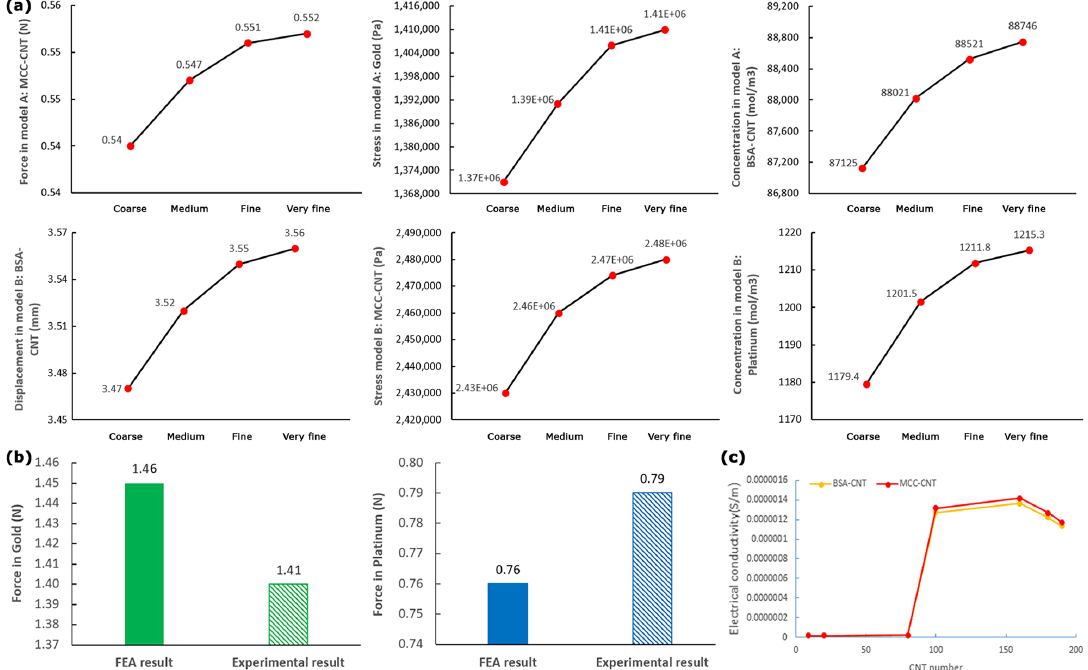
Figure 4. ( a ) Grid independence study for force, linear displacement, cation concentration, and stress values. ( b ) Comparison of FEA and experimental force results. ( c ) Electrical conductivity in BSA-CNT and MCC-CNT nanocomposites in regard to the CNT numbers.